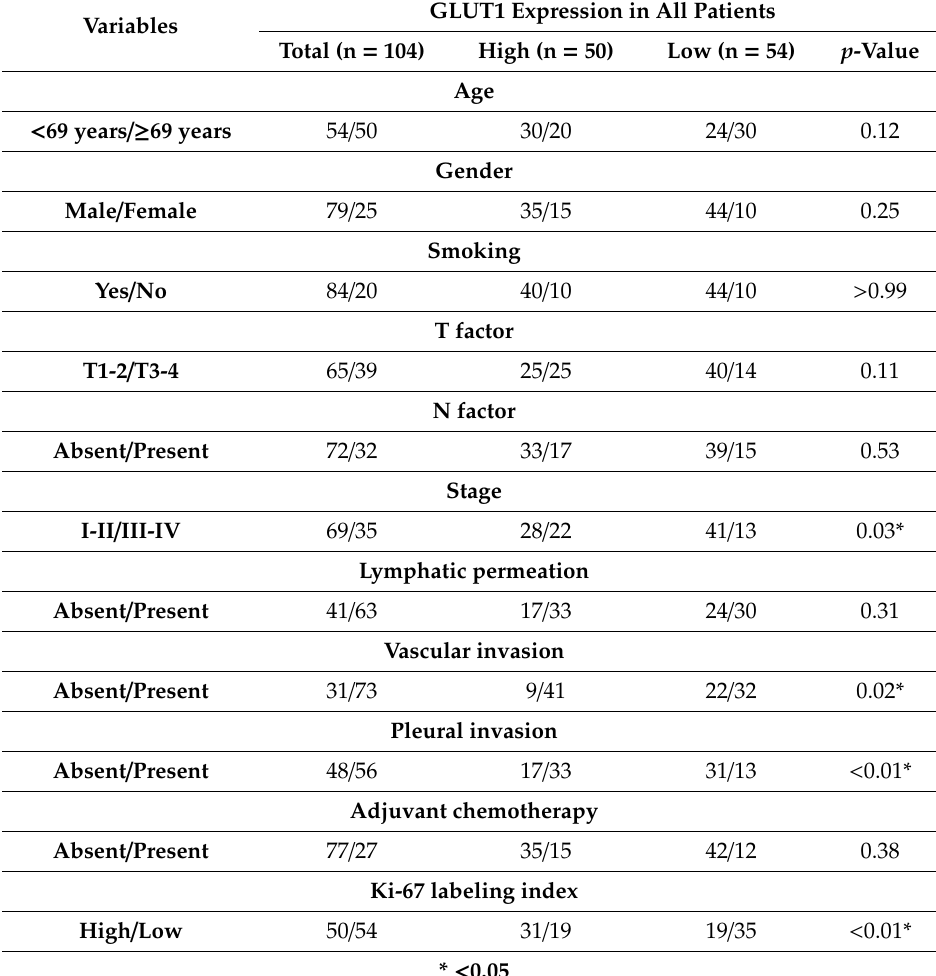
Table 1. Patient demographics according to GLUT1